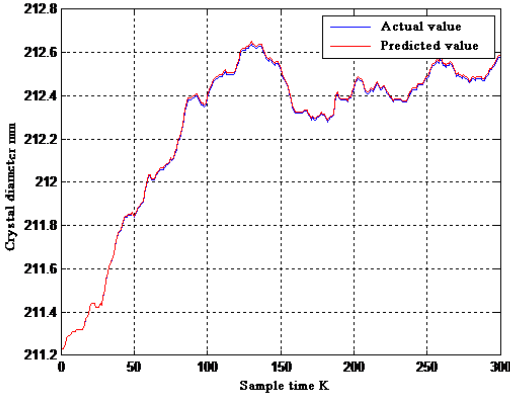
Figure 9. Experiment results: crystal diameter curves of measured and predicted value. From Figure 9, the predicted value of the proposed model has little deviation from the actual measured value, and the two curves almost completely overlap. This shows that the proposed model performs the best at diameter